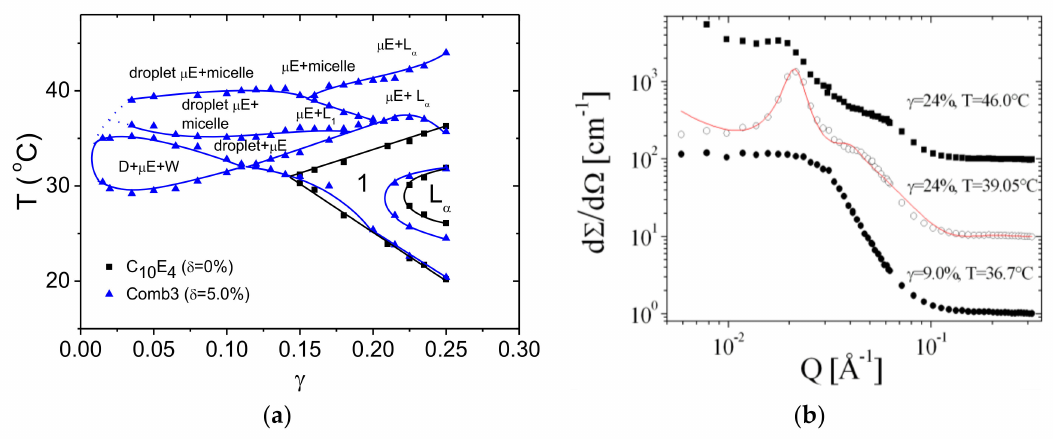
Figure 10. ( a ) Phase diagram showing temperature versus surfactant amount for the system containing Comb 3 (blue symbols and lines). The black symbols and lines show the behavior of the system without polymer. The new phases (coexisting phases) are denoted: (largely polymeric) micelles, droplet microemulsions (droplet µ E, D, or L 1 ), bicontinuous microemulsions ( µ E or 1), and lamellar microemulsions (L α ). The expelled phases are either oil droplets (D) or water-rich phases (W). All the phases were supported by visual inspection and crossed polarizers, SANS measurements, and NMR. ( b ) Representative SANS patterns of the ordered phases to support the classification of the phase structure. The curves for 39.05 and 46.0 ◦ C are multiplied by factors 10 and 100, respectively. A model fit for lamellar microemulsions is indicated by the red